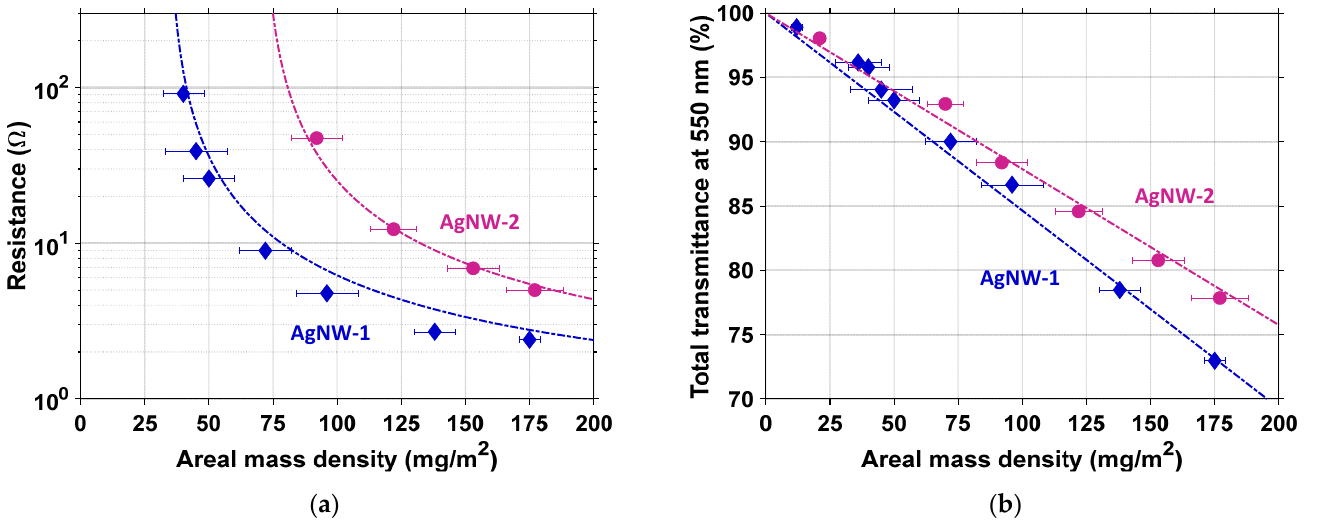
Figure 2. ( a ) Dependency of resistance, R , of the AgNW network versus amd ; ( b ) Dependency of the total transmittance, T r , of the AgNW network versus amd . Symbols (blue diamond and pink circle) correspond to experimental data of AgNWs (AgNW-1 and AgNW-2, respectively), while dashed lines correspond to R and T r fitting using Equation (2) and Equation (3), respectively. The substrate contribution was removed.